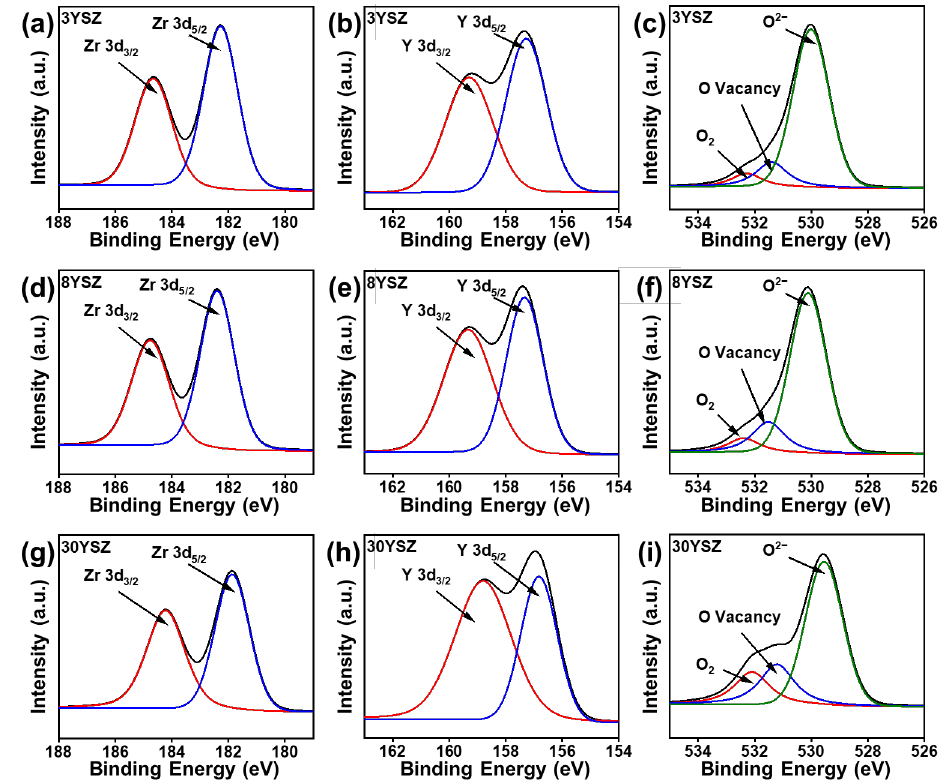
Figure 4. XPS spectra of 3YSZ (top), 8YSZ ( middle ), and 30YSZ ( bottom ) nanospheres: ( a , d , g ) Zr 3d, ( b , e , h ) Y 3d, and ( c , f , i ) O